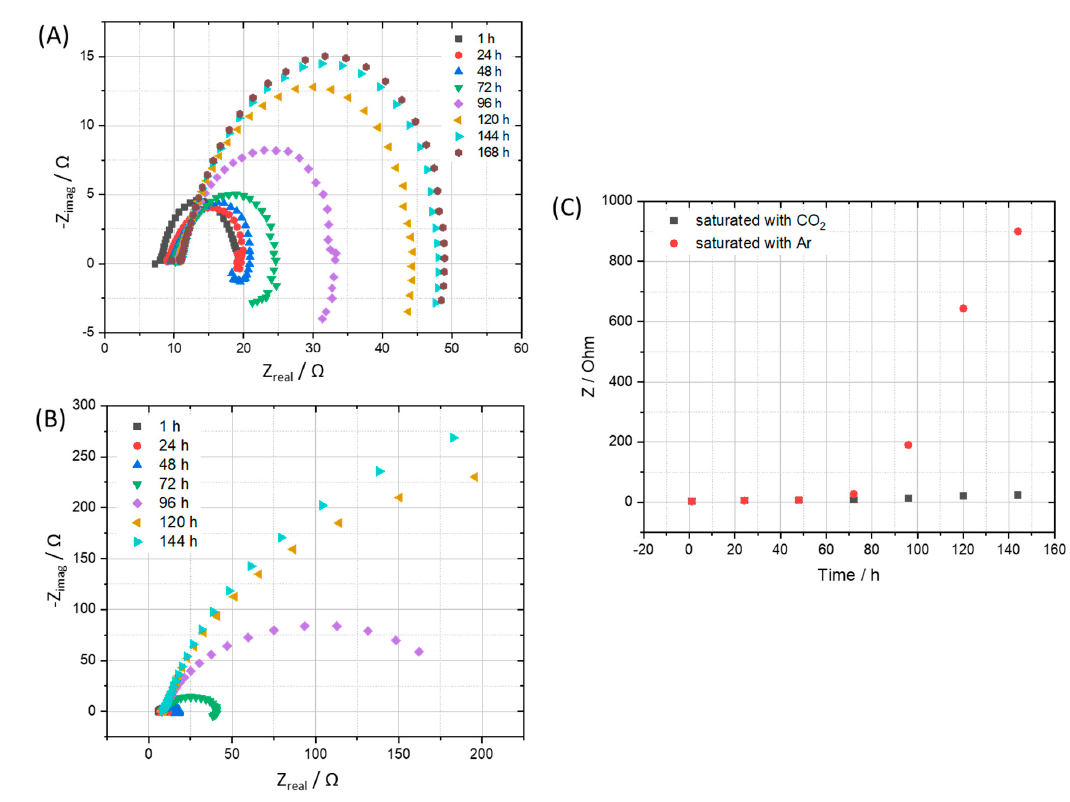
Figure 4. EIS spectra of coupon exposed to the condensate that saturated with ( A ) CO 2 in comparison with ( B ) Ar and corresponding calculated corrosion resistance ( C ).